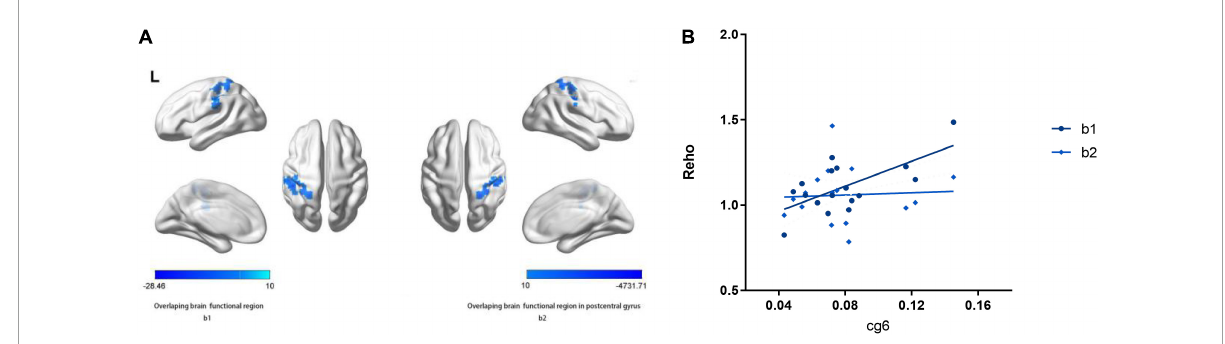
FIGURE4 Main effects of the hTERT gene promoter methylation on ReHo. (A) b1 shows decreased ReHo in left inferior parietal lobule, postcentral gyrus negative associated with cg1295648 methylation level and social function scores in PD patients. b2 shows decreased ReHo in left postcentral